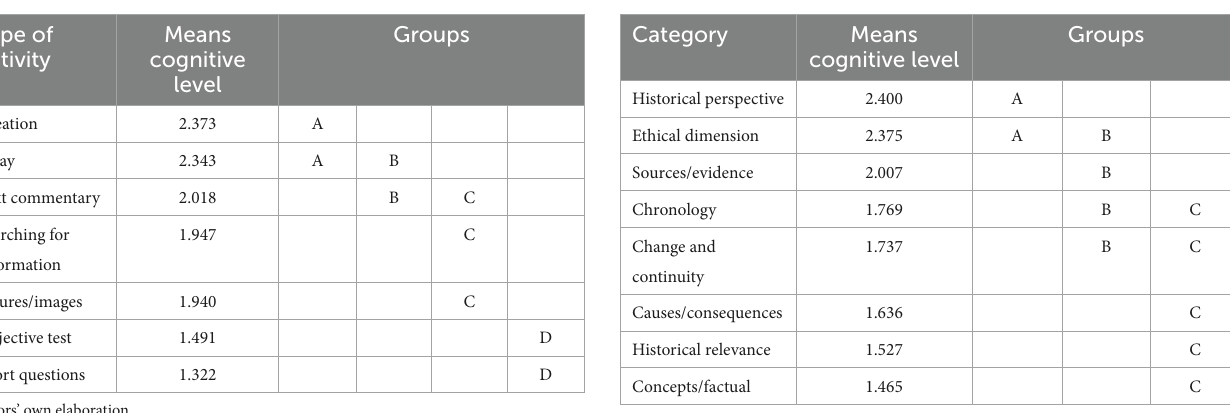
TABLE 11 Tukey-B test cognitive level/type of activity.